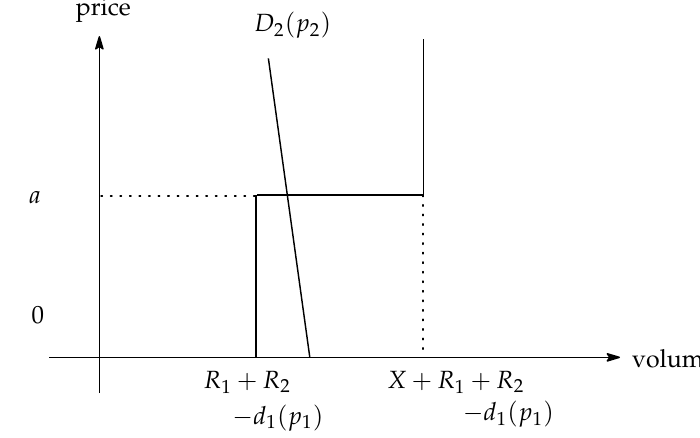
Figure 2. Date 2 market